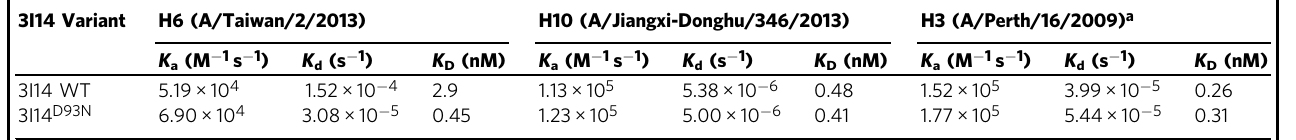
Table 1 Binding data for 3I14 and 3I14 D93N